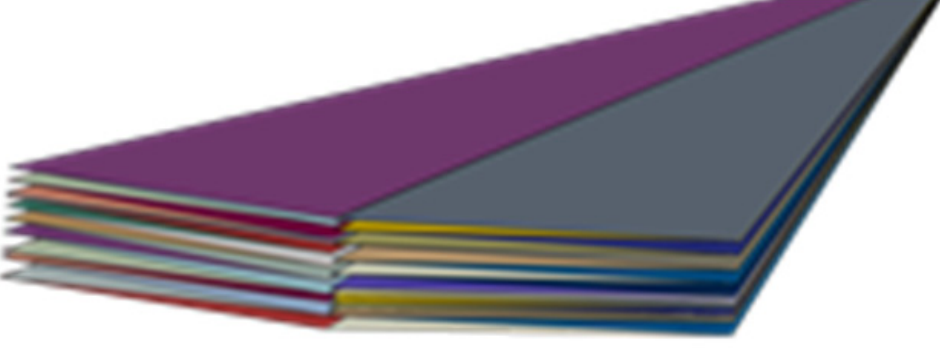
Figure 3. Gore Figure 3. Gore model. Figure 3. Gore model.